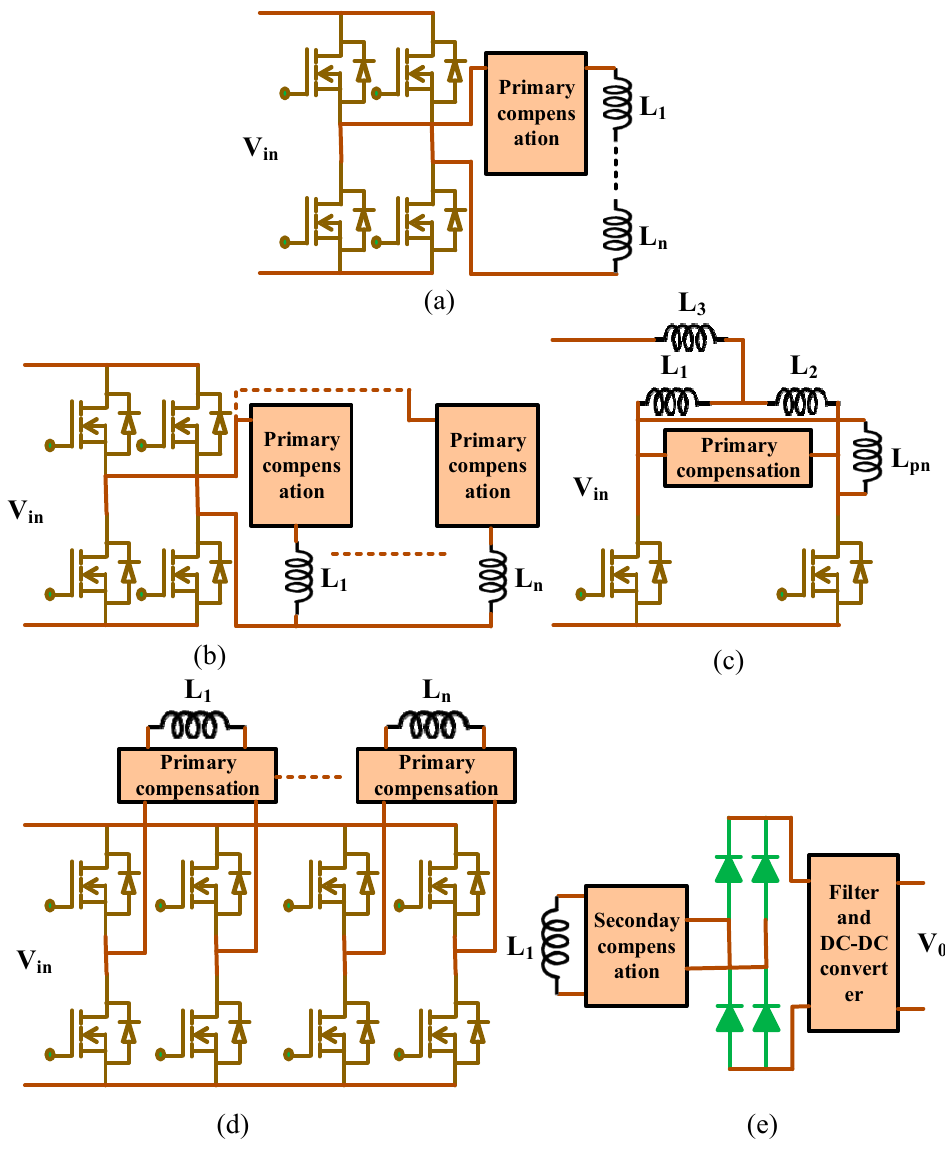
Figure 6. Various high-frequency converter topologies for DWPT feeding; ( a ) multiple coils connected in series; ( b ) multiple coils connected in parallel; ( c ) push–pull converter; ( d ) multi-phase converter; ( e ) secondary compensation